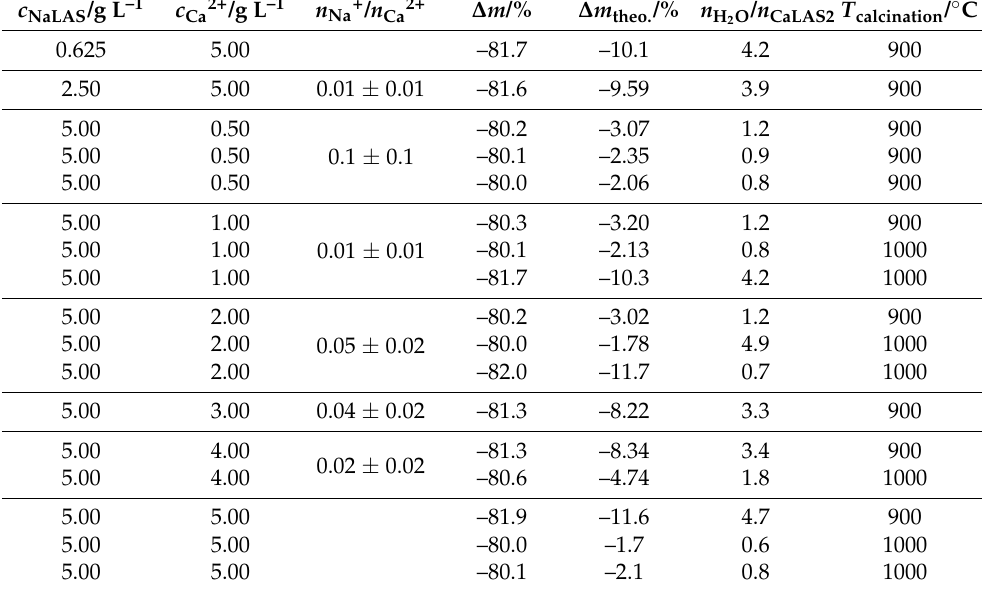
Table 1. Concentration of sodium linear alkylbenzene sulfonate (NaLAS) and Ca 2+ in surfactant— CaCl 2 dispersions, the Na + :Ca 2+ molar ratio (with standard deviation) in the CaLAS 2 precipitates forming in the dispersions, weight loss upon calcination ( ∆ m ), the difference between the final and theoretical mass assuming the CaLAS 2 → CaSO 4 reaction upon calcination ( ∆ m theo. ), the calculated initial H 2 O:CaLAS 2 molar ratio based on this difference, and the temperature of calcination. c NaLAS /g L